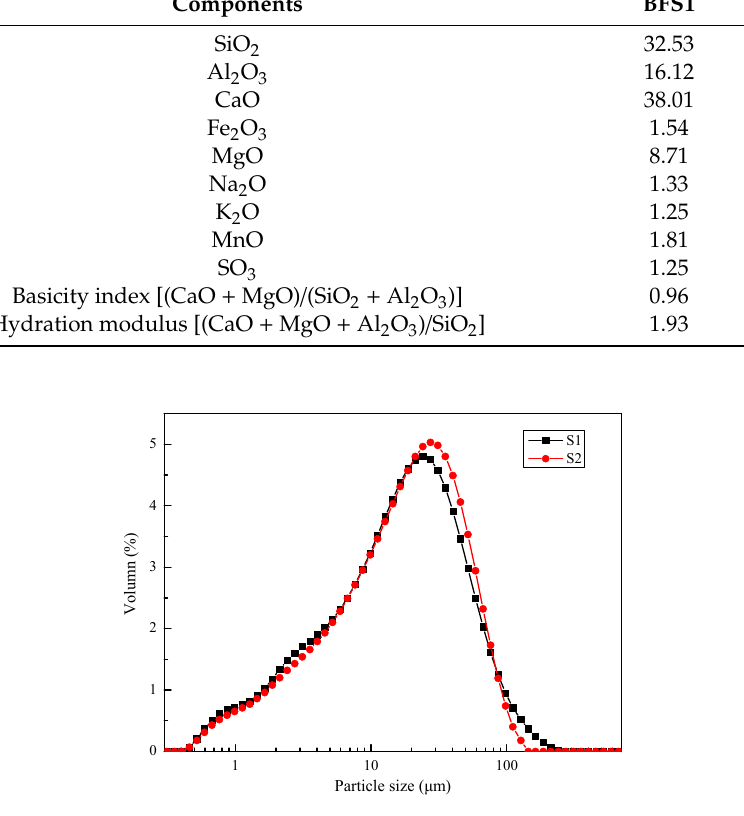
Figure 1. Particle size distributions of the BFS. Table 2. Characteristic particle diameters and BET surface areas of BFS.